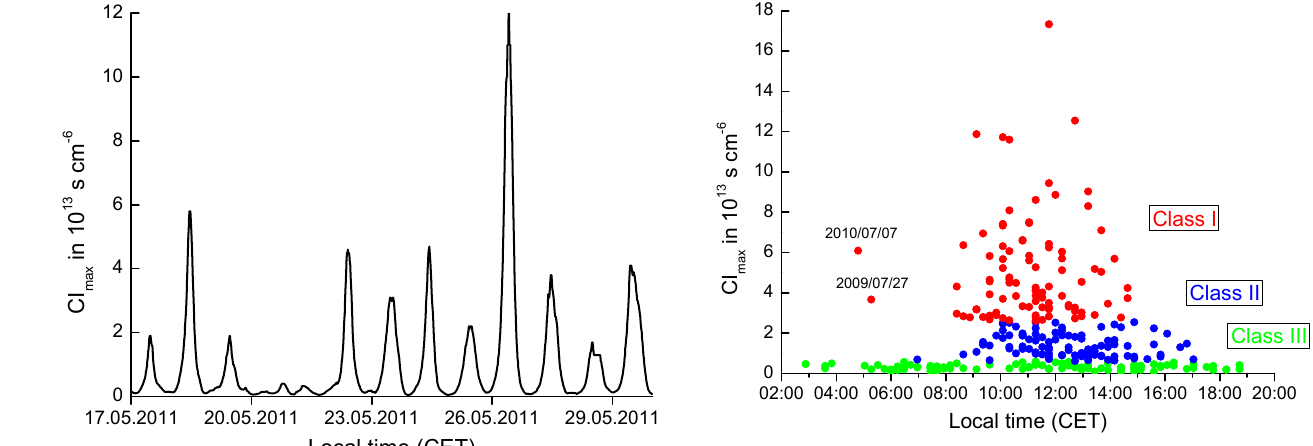
Figure 4. Exemplary time series of the convolution integral CI from 16–30 May 2011 indicating the intensity of new particle formation.